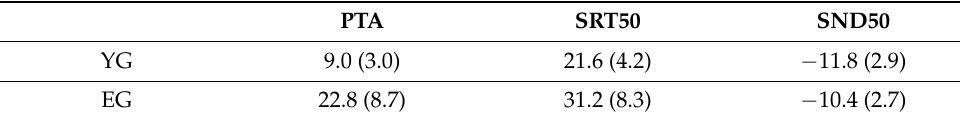
Table 2. Hearing characteristics depending on the group. Means and